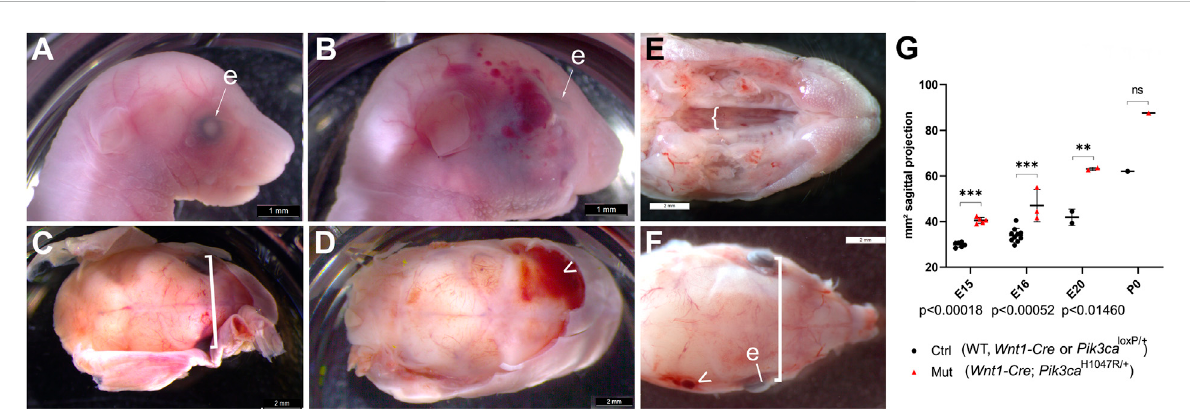
Mutants compared to their unaffected control littermates expressing only one or neither of the Wnt1-Cre or Pik3ca H1047R/+ alleles. (A) At E20, fetal head from control littermate of (B) at same magni fi cation, facing right. (B) At E20, mutant fetuses and newborns had visible megalencephaly, displaced eyes above an enlarged maxillary primordium and skull vault, larger external ears, a longer nose, and facial vascular malformations or tumors, sometimes hemorrhagic (arrowheads). Bar, 1 mm. (C) Distinct E20 control fetus, skin removed and relative interocular distance indicatedinsquarebracket.Bar,2 mm. (D) DistinctE20mutantfetus,skinremovedtoseehemorrhagefromrupturedvascularlesions.Bar,2 mm. (E) Wnt1-Cre +/ ° ; Pik3ca H1047R/+ mutant newborn at P0, view of cleft palate (bracket) after removal of skin and jaw. Bar, 2 mm. (F) Wnt1-Cre +/ ° ; Pik3ca H1047R/+ mutant newborn at P0, coronal view of cleft palate (bracket) after removal of skin and jaw, relative interocular distance indicated in square bracket at same scale as (C) . Arrowhead, vascular lesion. Bar, 2 mm. (G) Maximum sagittal plane surface projection of lateral photographs from embryos at the indicated stages between embryonic day (E)15 and birth (P0), of either control (ctrl) littermate or Wnt1-Cre +/ ° ; Pik3ca H1047R/+ (mut) genotype. Through the last third of gestation, mutant heads were signi fi cantly larger than controls, as was the head of the sole neonate recovered. ctrl, control; e, eye; mut, mutant; ns, not signi fi